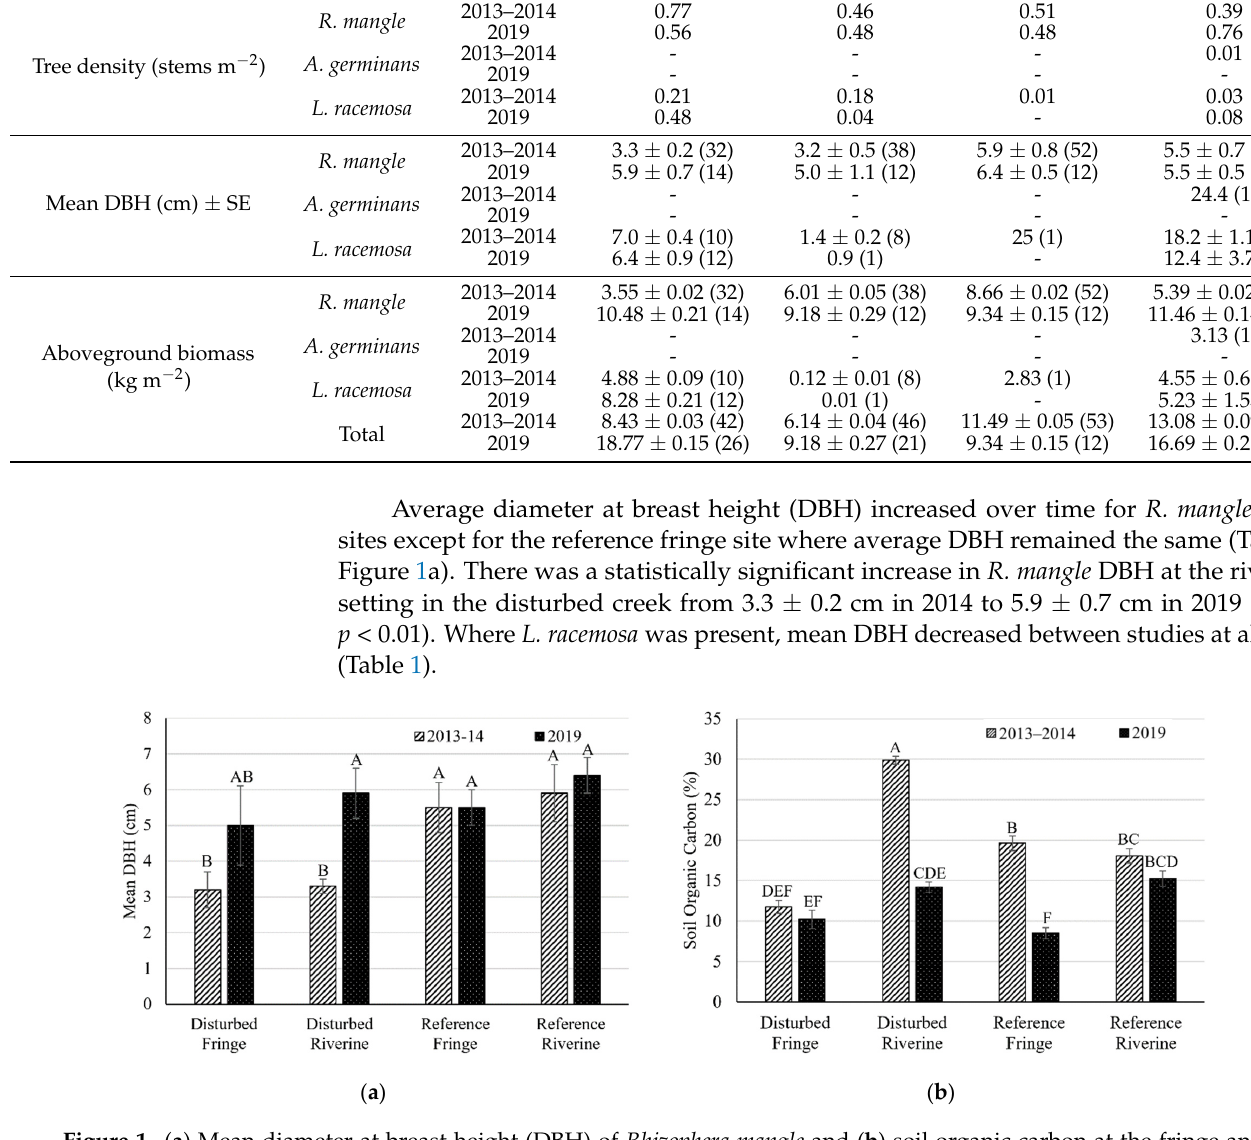
Figure 1. ( a ) Mean diameter at breast height (DBH) of Rhizophera mangle and ( b ) soil organic carbon at the fringe and riverine settings in the disturbed and reference creeks in the period 2013–2014 [10] and 2019 (this study). Error bars represent ± standard error. Similarity letters represent the results of a Tukey HSD test.